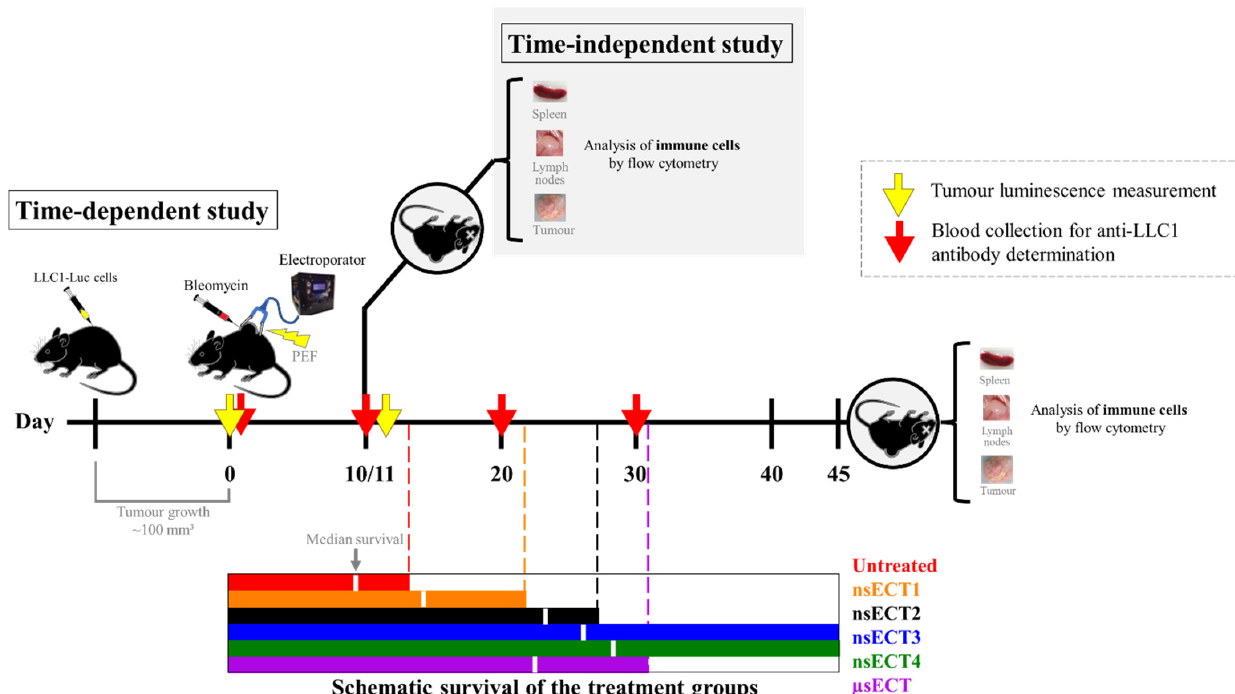
Figure 1. Schematic overview of the time-dependent and time independent studies.